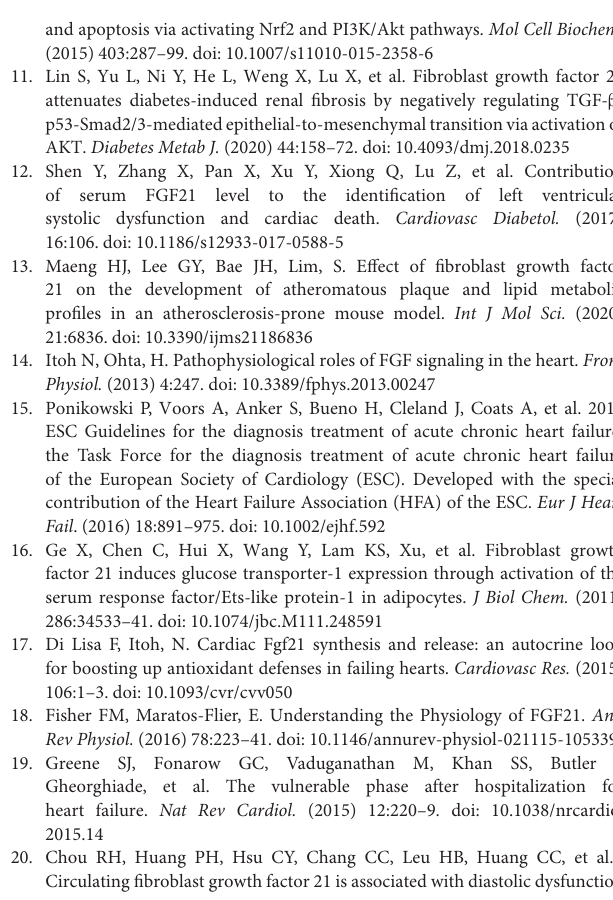
Supplementary Figure 1 | Pairwise comparison of the ROC curve between FGF21 and NT-proBNP in predicting all-cause death at 3 (A) and 6 months (B) after discharge. FGF21 predicted all-cause deaths better than NT-proBNP for both 3 ( p < 0.001) and 6 months ( p <